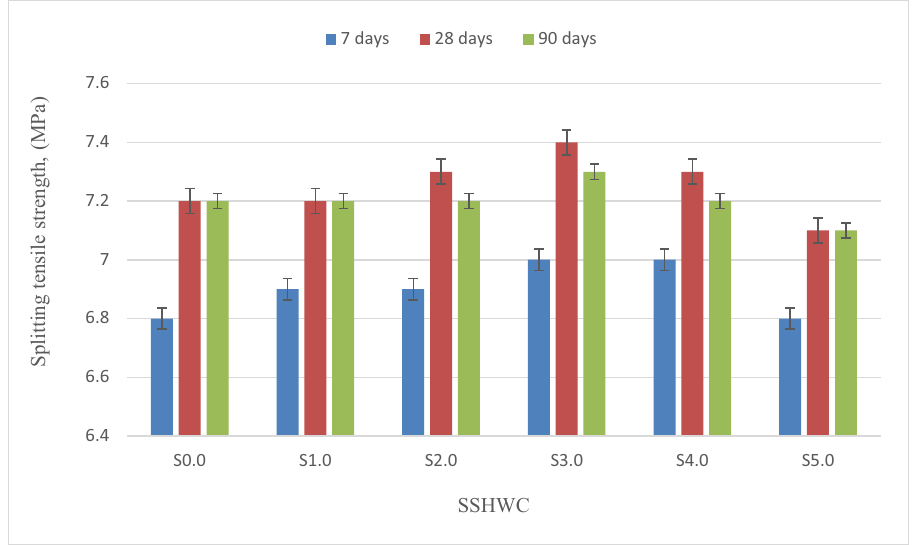
Figure 10: Splitting tensile strength of SSHWC